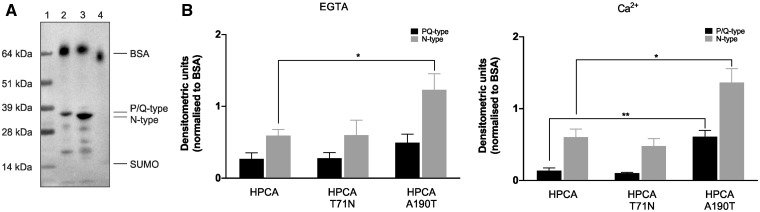
Hippocalcin wild-type and mutants interact with P/Q- and N-type voltage-gated calcium channels. P/Q- (residues 1898-2035), N-type (residues 1836-1983) VGCC fragments and SUMO protein were separated by SDS-PAGE and transferred to nitrocellulose. Binding proteins were detected with biotinylated hippocalcin or hippocalcin mutants in the absence or presence of Ca2+. (A) Representative overlay blot after detection with streptavidin-HRP. Lane 1: molecular weight ladder, lane 2: SUMO-P/Q- purified protein, lane 3: SUMO-N-type purified protein, Lane 4: SUMO purified protein. Biotinylated BSA was added to the each sample and used as a loading control. (B) Quantification of hippocalcin binding to the P/Q- and N-type VGCC fragments using ImageJ showed calcium-dependent altered binding of A190T mutant to both P/Q- and N-type channels compared to the wild-type protein. All experiments were performed in 3-6 replicates and expressed as normalised mean ± SEM.